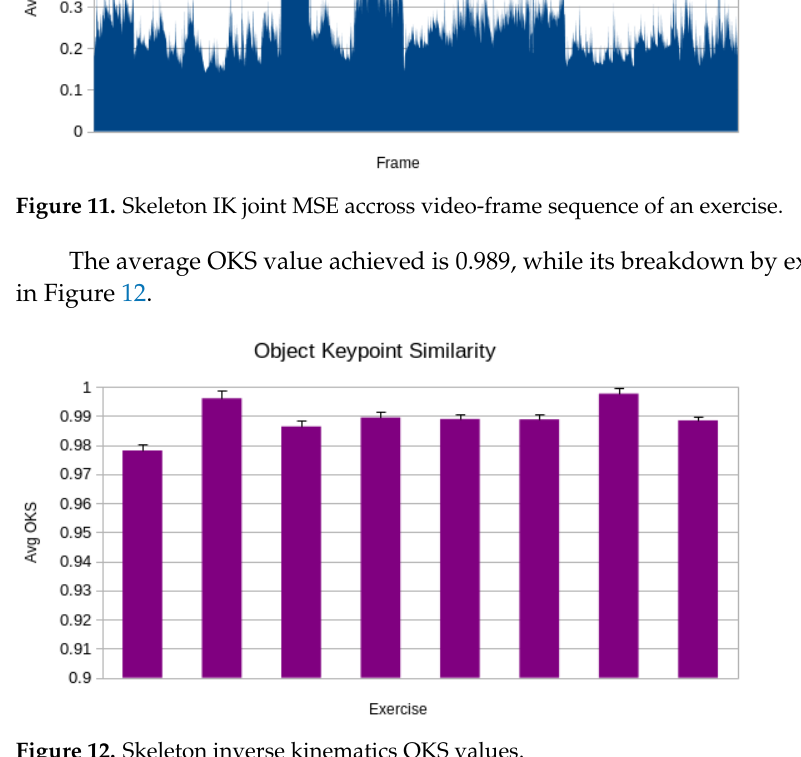
Figure 12. Skeleton inverse kinematics OKS values. The PCK values thresholded at various detection confidence rates are given in Table 2. amplitude of movement and are located at an upper part of the